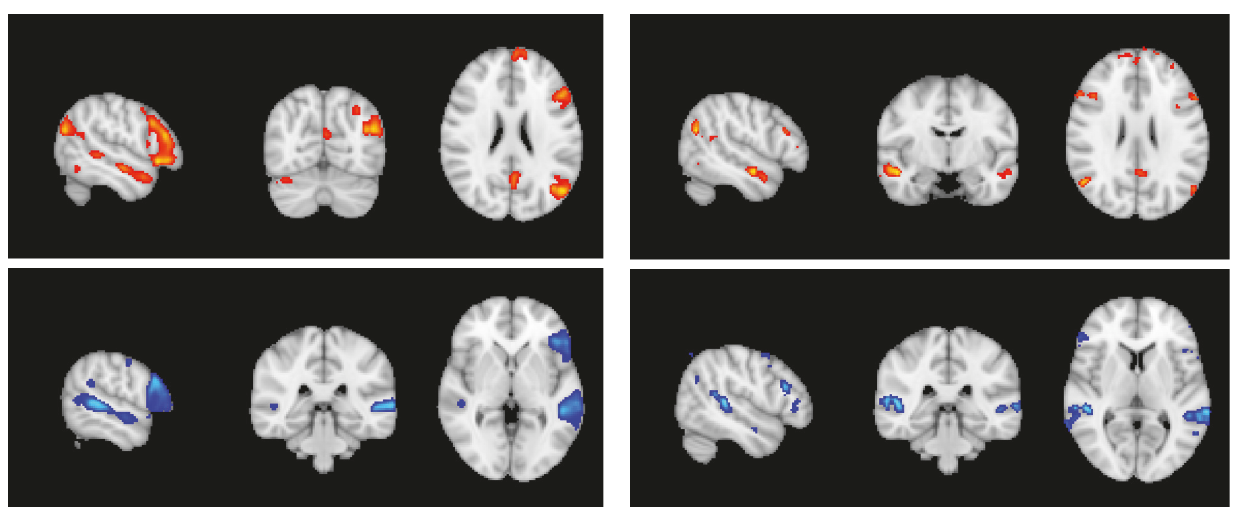
(a) Auditory group map of participants classified as left-hemisphere lan- guage dominant (top), visual group map of participants classified as left- hemisphere language dominant (bottom) (note: images are in radiological orientation, where right=left)